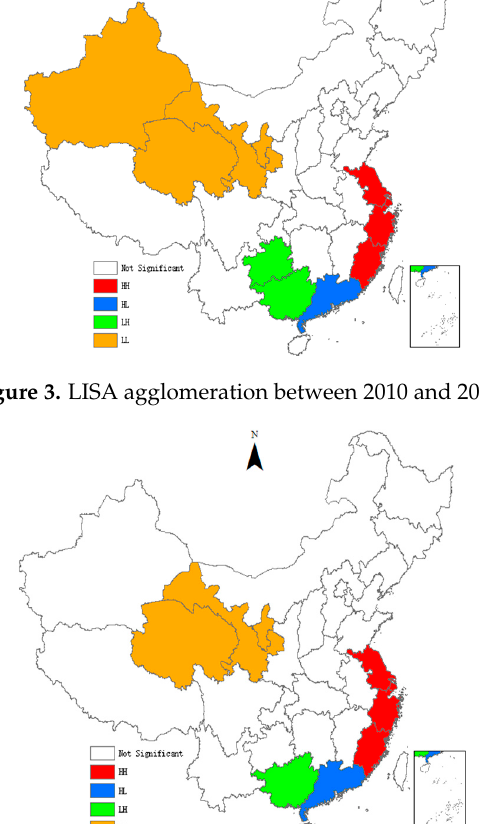
Table 5. Estimation results at the national level using the four methods.